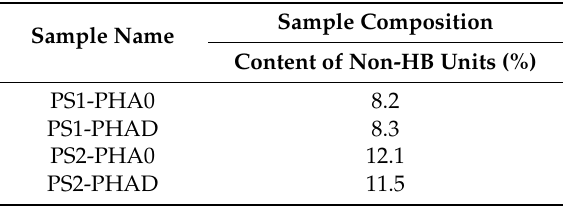
Table 6. The chemical composition of PSx-PHA samples before (0) and after partial depolymerization for ESI-MS/MS analysis (D) (determined from 1 H-NMR analysis).